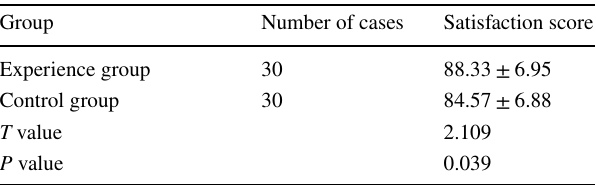
Table 5 Comparison of two groups of interns' satisfaction scores (scores)